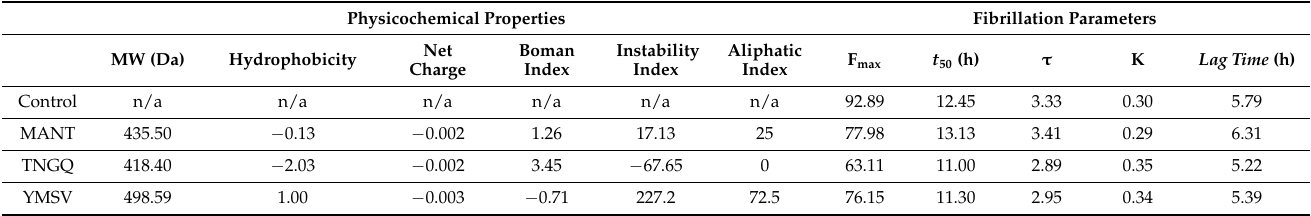
Table 1. Physicochemical properties and fibrillation kinetic parameters derived from ThT fluorescence assay of IAPP fibrillation in the absence (control) and presence of tetrapeptides MANT, TNGQ, and YMSV.